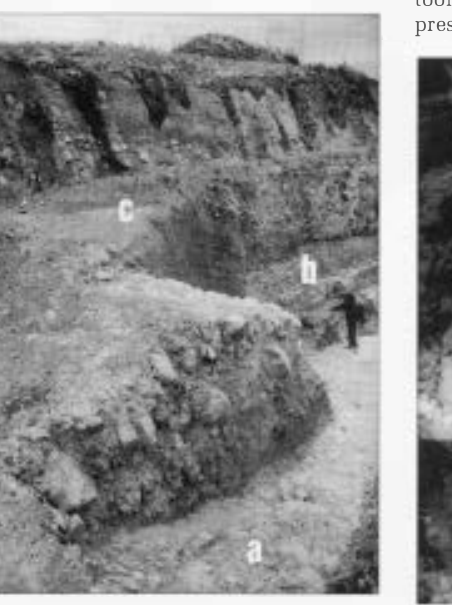
lith covering the Downs moved down slope in the form of mass-movement deposits.